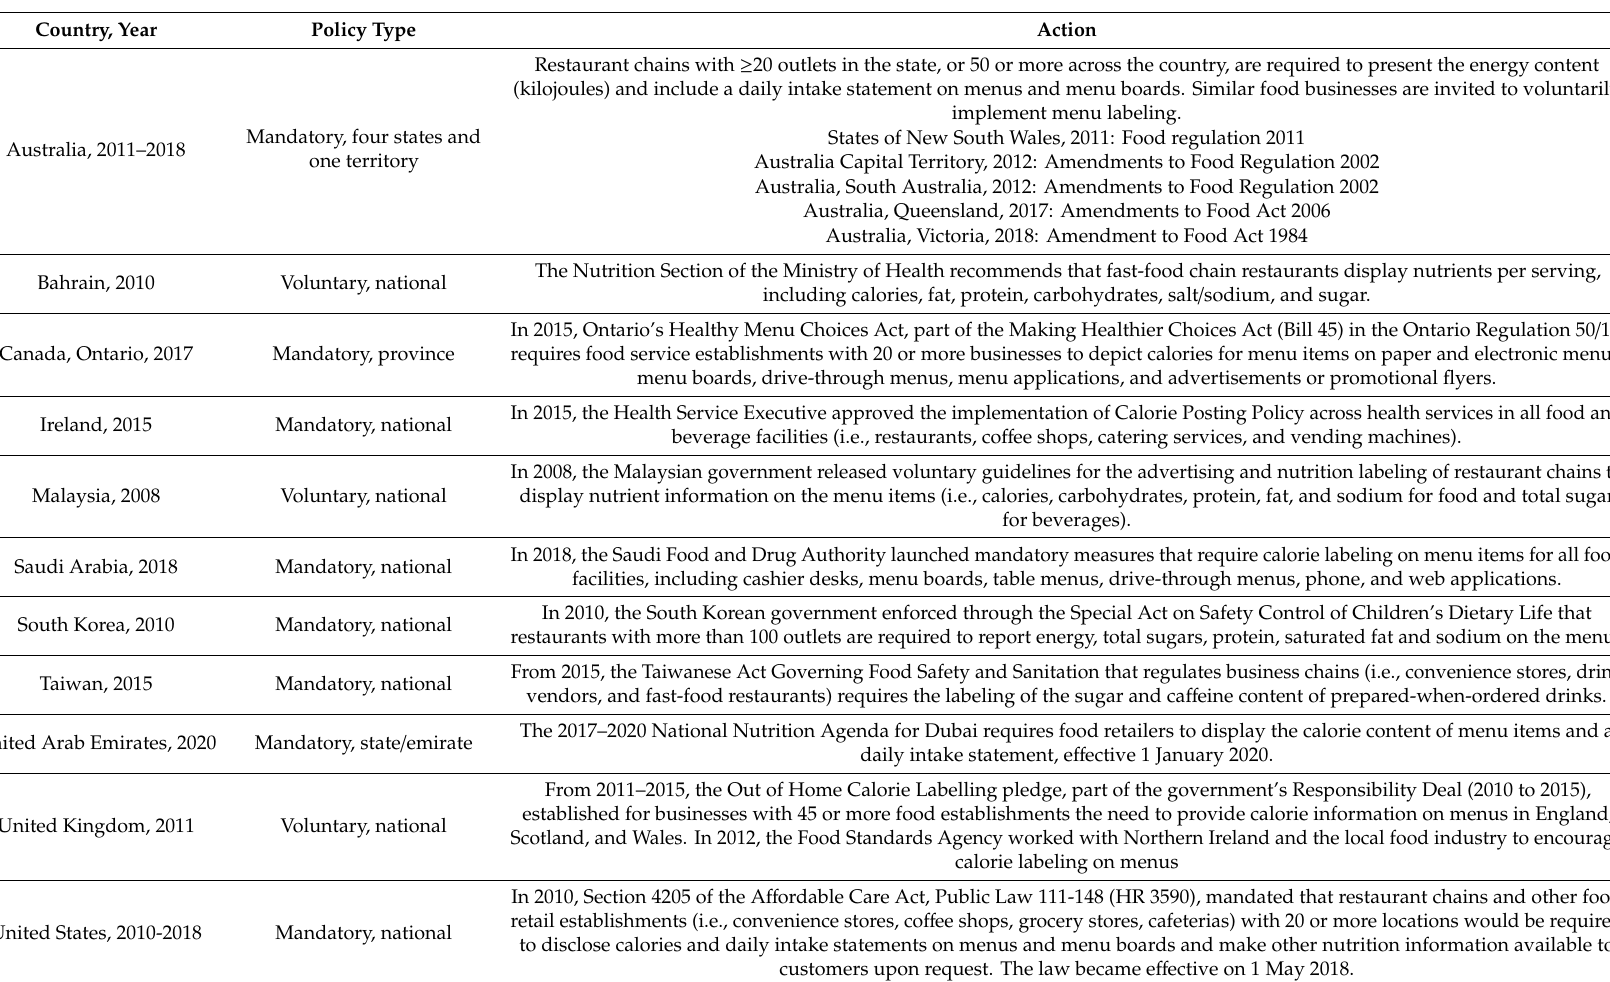
Table 3. Implemented menu labeling policies across countries worldwide,